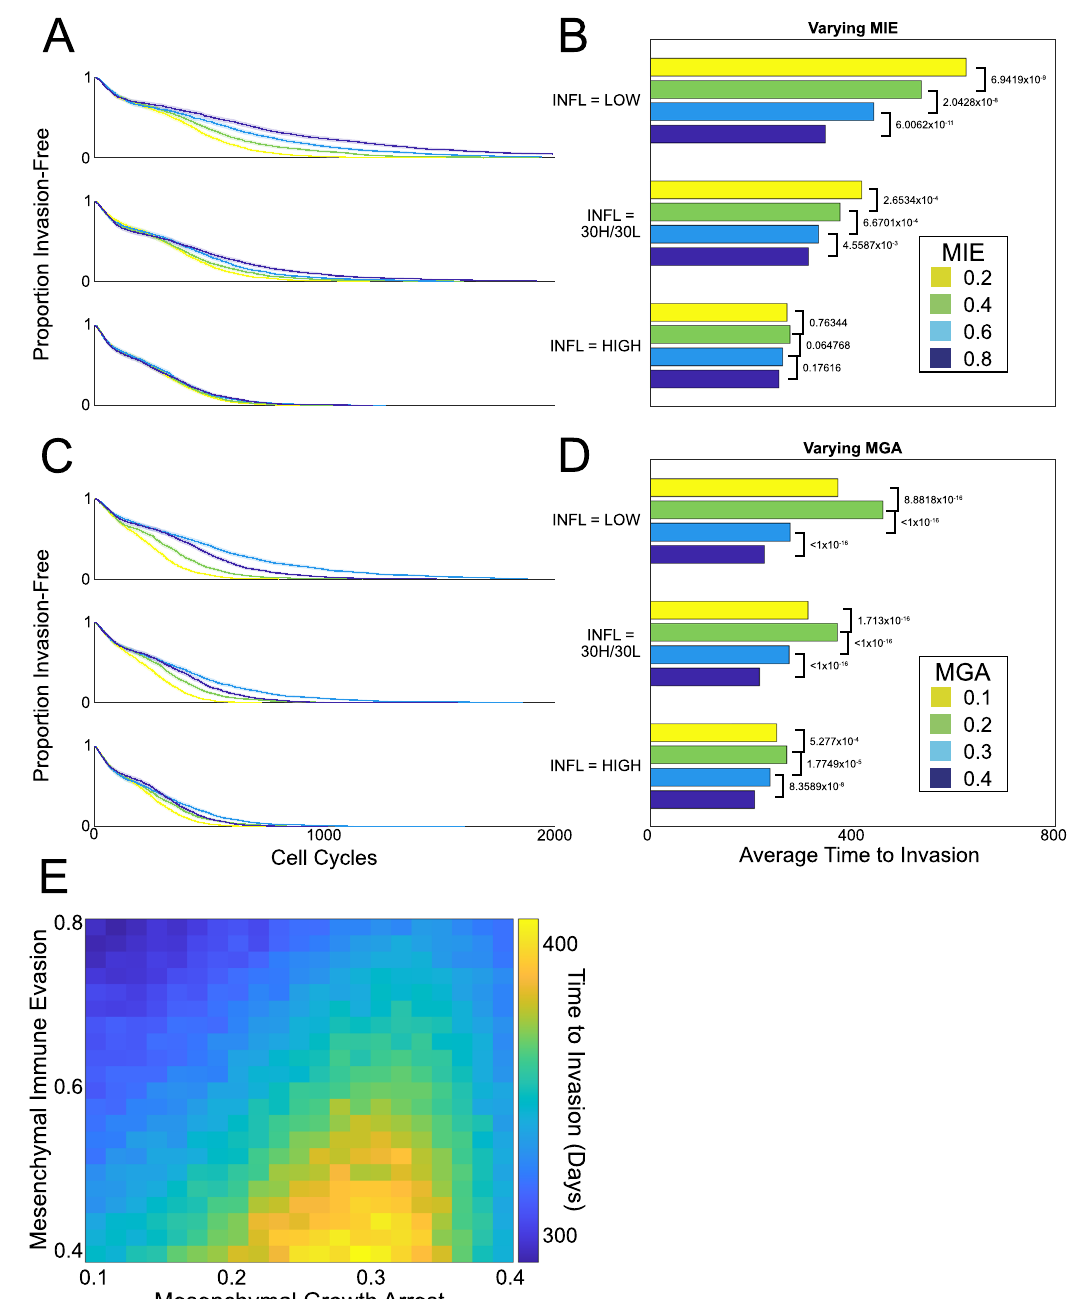
Fig. 4 Effects of in fl ammation on the time to invasion under different cycling schemes. A , B As MIE varies, survival curves (each of 200 patients) and corresponding bar plots to summarize the mean time to invasion for each cohort are shown. P values for log-rank tests on the corresponding survival curves are shown. C , D . As MGA varies, survival curves and corresponding bar plots to summarize the mean time to invasion for each cohort are shown. P values for log-rank tests on the corresponding survival curves are shown. E Summary of the effects of MIE and MGA on invasion-free